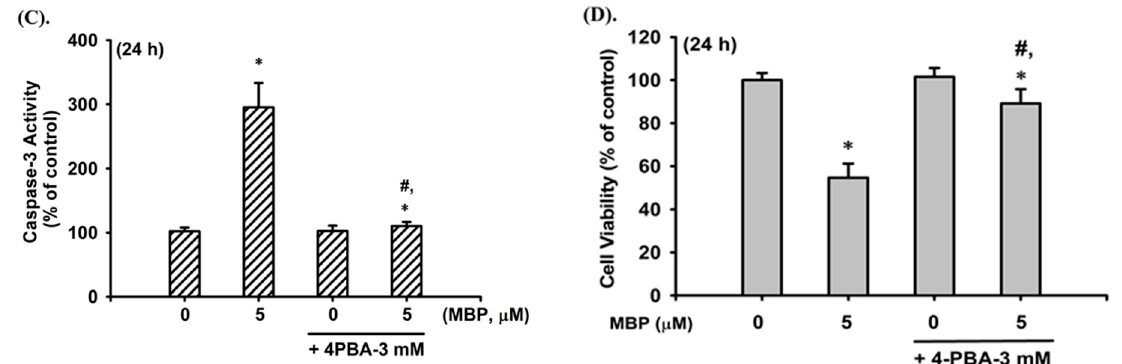
Figure 3. Involvement of ER stress-regulated signaling pathways in MBP-induced β -cell apoptosis. ( A ) RIN-m5F cells were treated with or without MBP (5 μ M) for various time intervals (8–24 h). The protein expression of the ER stress-related proteins GRP 78, GRP 94, CHOP, and caspase-12 was examined using Western blot analysis. Additionally, RIN-m5F cells were treated with or without MBP (5 μ M) for 24 h in the absence or presence of 3 mM 4-phenylbutyric acid (4-PBA; the pharmacological inhibitor of ER stress, 1 h treatment prior to MBP exposure). ( B ) The protein expression of GRP 78, CHOP, pro-caspase-12, and cleaved caspase-3 and -7 was examined using Western blot analysis. The quantification was performed using densitometric analysis. ( C ) Caspase-3 activity was determined using the caspase-3 activity fluorometric assay kit. ( D ) Cell viability was detected using the MTT assay. Data are presented as the mean ± S.D. of four independent experiments assayed in triplicate. * p < 0.05 compared to the vehicle control. # p < 0.05 compared to treatment with MBP alone.